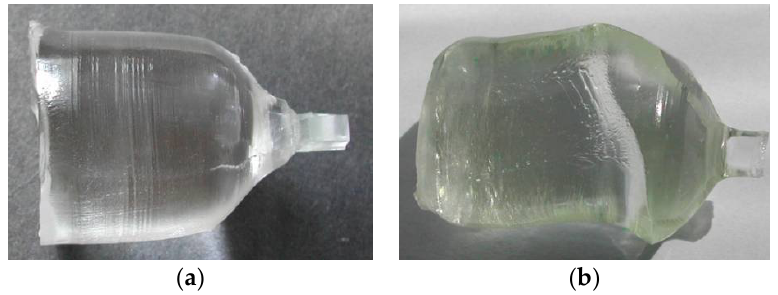
Figure 1. 1 mol% ( a ) and 5 mol% ( b ) Dy doped Li 6 Y(BO 3 ) 3 single crystals grown by the Czochralski method. The cylindrical part is 30 mm long and 25 mm in diameter.